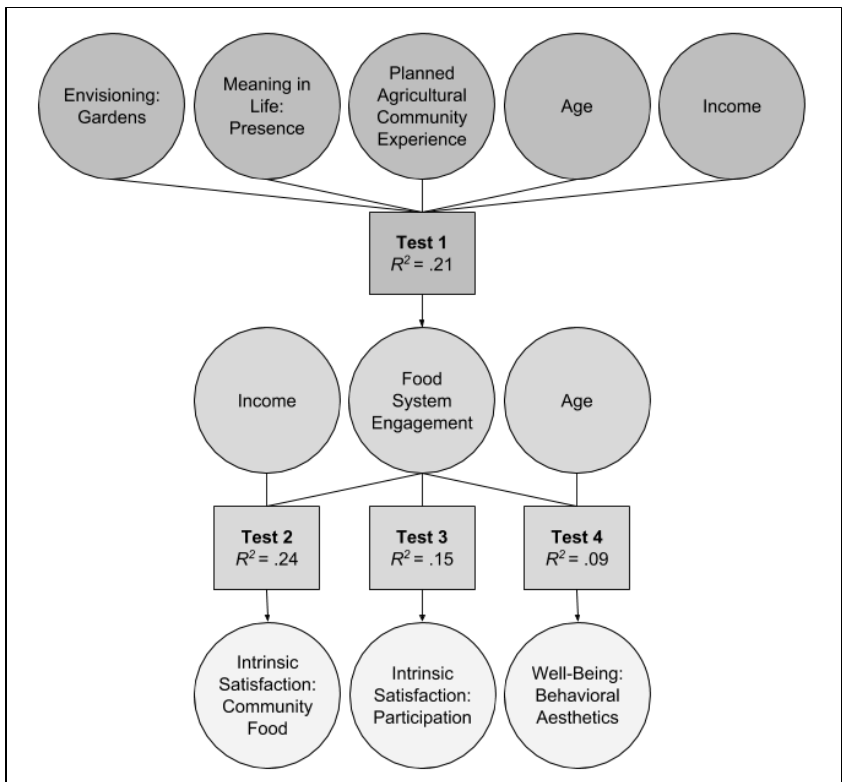
Figure 1. Diagram Outlining Regression Tests Described in the Sections “ Which Variables Contribute to Food Engagement? ” and “ Which Variables Does Food Engagement Contribute to?